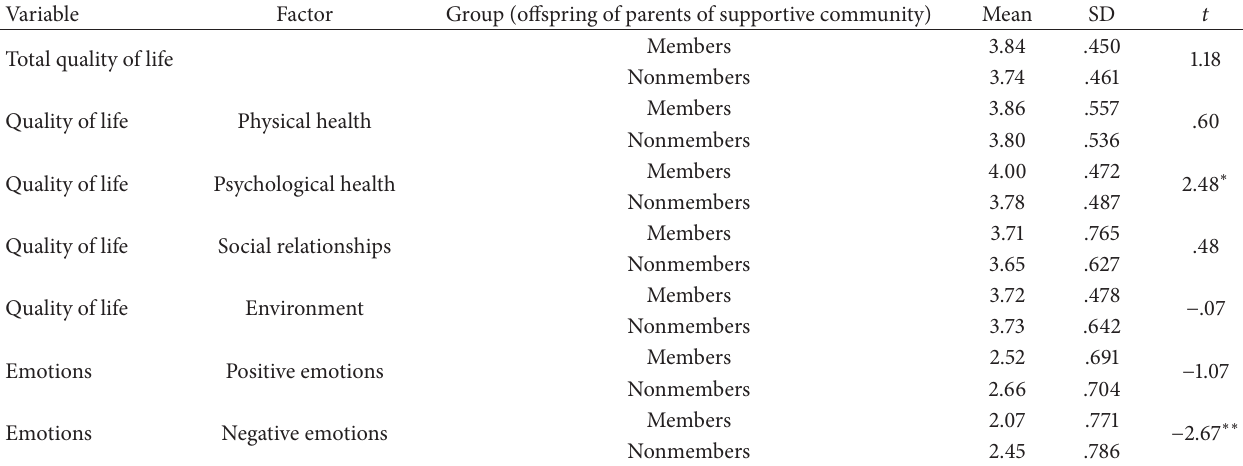
Table 3: Differences in quality of life between offspring of supportive community members ( 𝑁 = 55 ) and nonmembers ( 𝑁 = 64 ). Variable